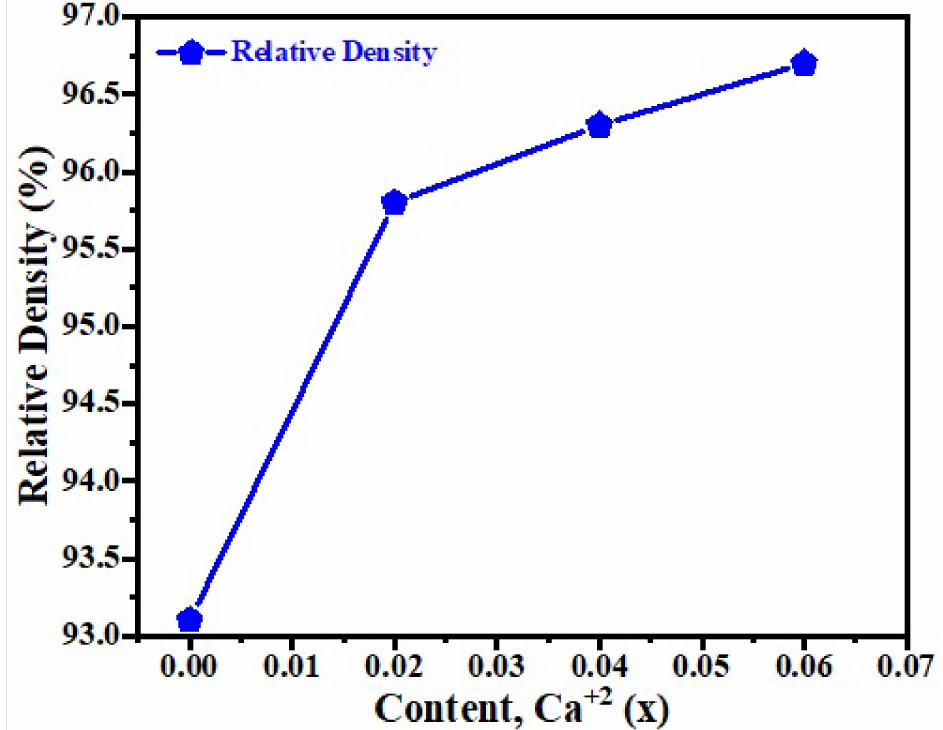
Figure 2. The relative density of (Sr 1 − x Ca x ) 5 Ti 4 O 13 , 0 ≤ x ≤ 0.06